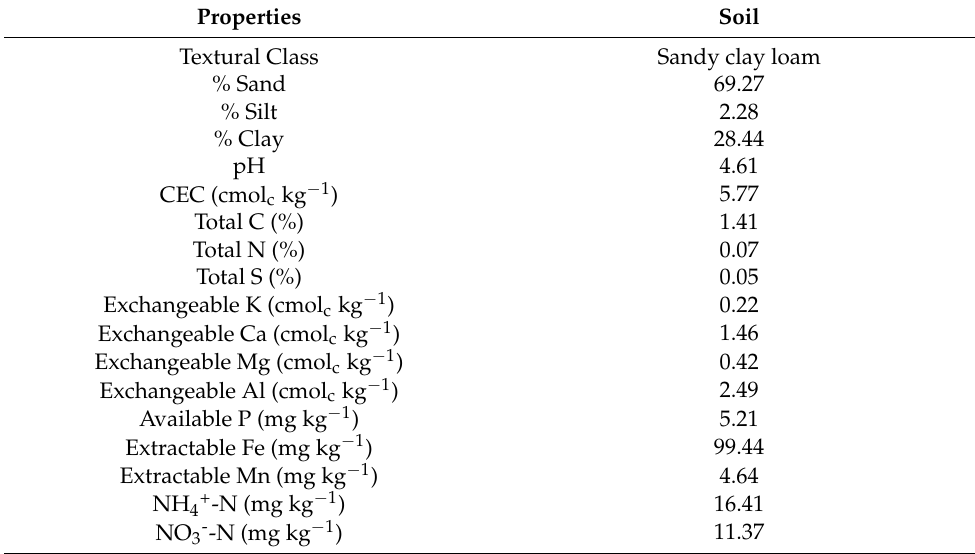
Table 1. Selected physicochemical properties of initial soil.